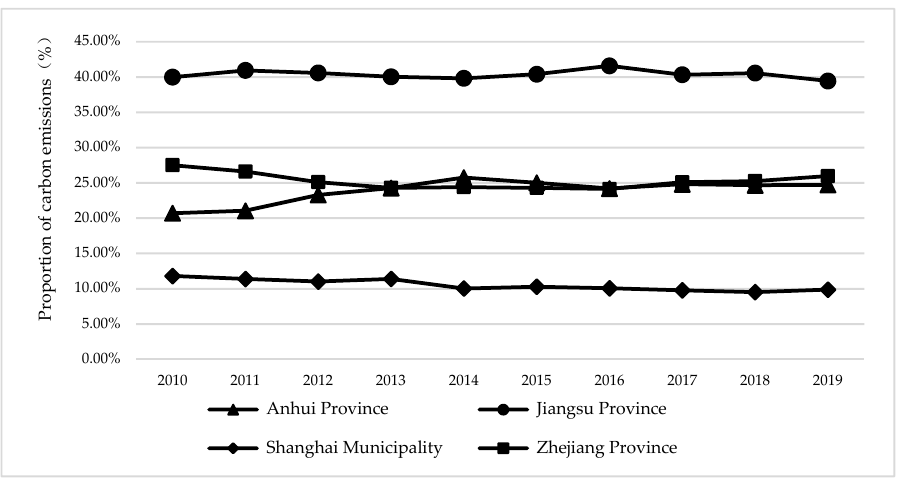
Figure 2. Proportion of carbon emissions from three provinces and one city in the Yangtze River Delta.